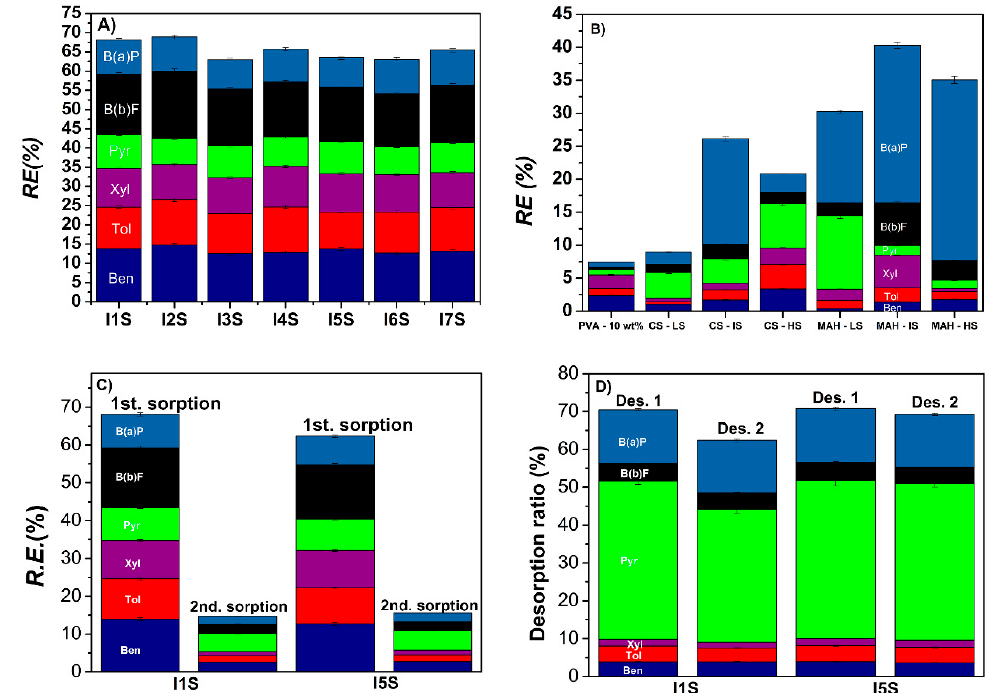
Figure 8. ( A ) Dependence on the adsorption capacity of the PVA/CS/MA- β -CD hydrogel with the intermediate swelling degree of solutions with the different initial concentration of BTXs and PAHs (see Table S1), at 25 °C; ( B ) PVA 10 wt % and blanks compositions, see the text for the meaning of blanks; ( C ) comparative results on the removal efficiency (RE) of the BTXs and PHAs by the hydrogels based on PVA/CS/MA- β -CD (IS), (I1S and I5S), after the first desorption (Des.1); and ( D ) desorption results for six miscible organics (BTXs and PAHs on PVA/CS/MA- β -CD hydrogels (IS). Table 4. Summary of removal efficiencies of hydrocarbons by different adsorbents.